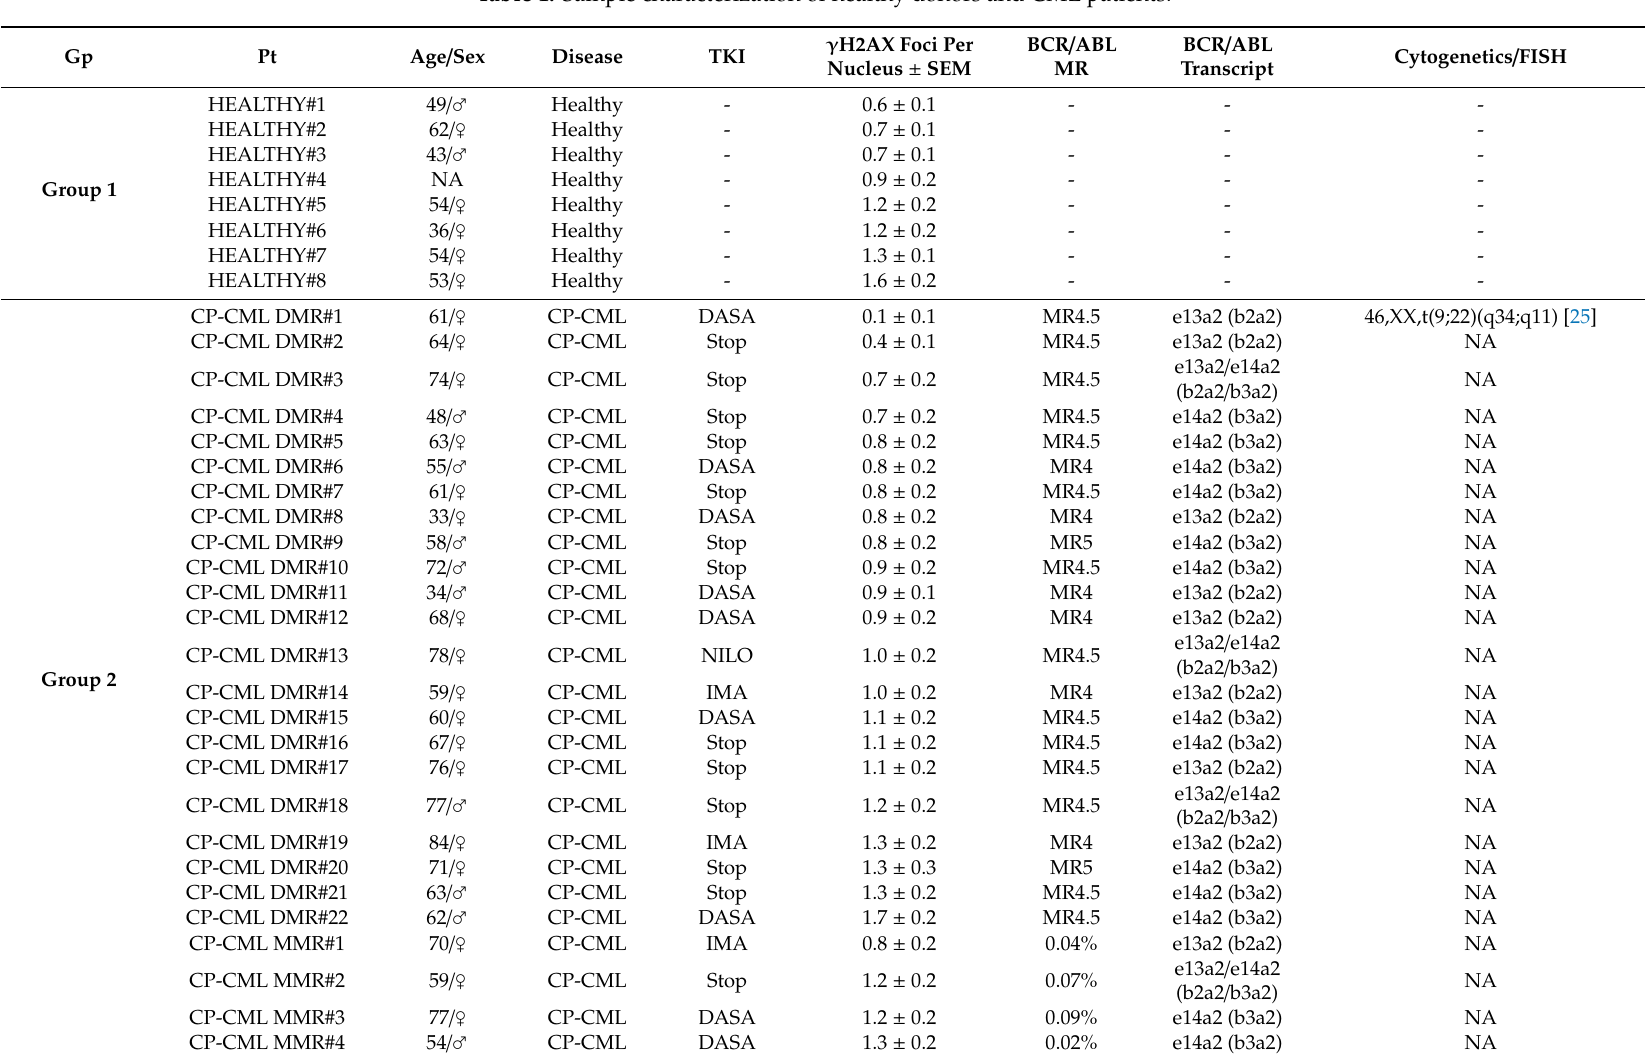
Table 1. Sample characterization of healthy donors and CML